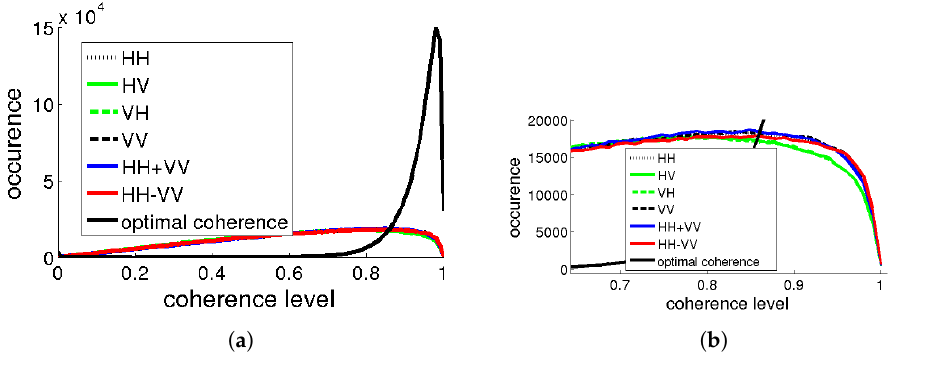
Figure 9. Coherence optimization.